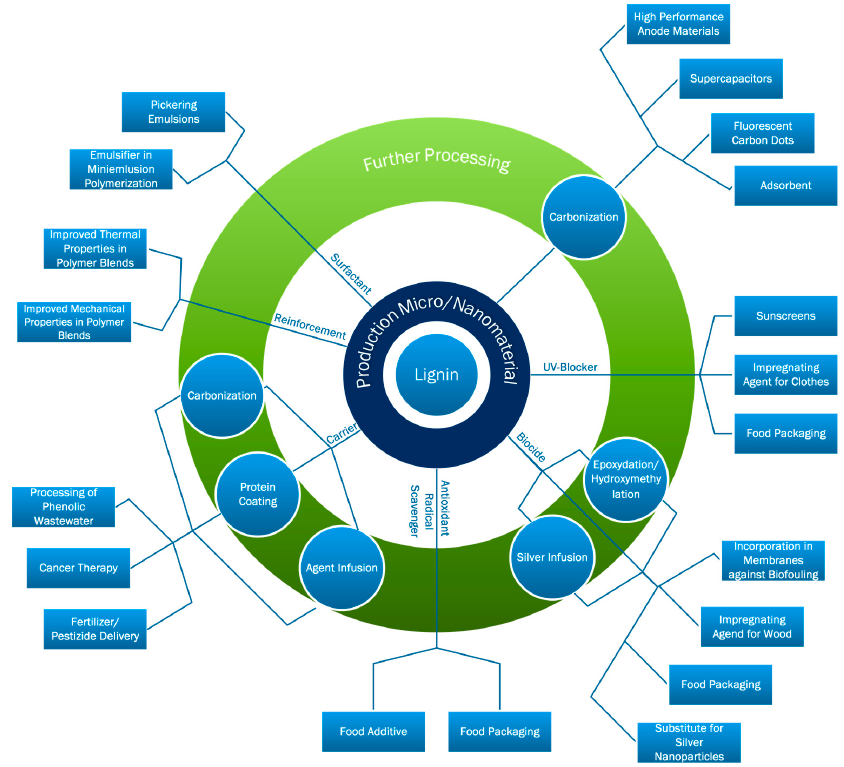
Figure 1. Overview of potential and investigated applications of lignin from micro- to nanosize published in literature .